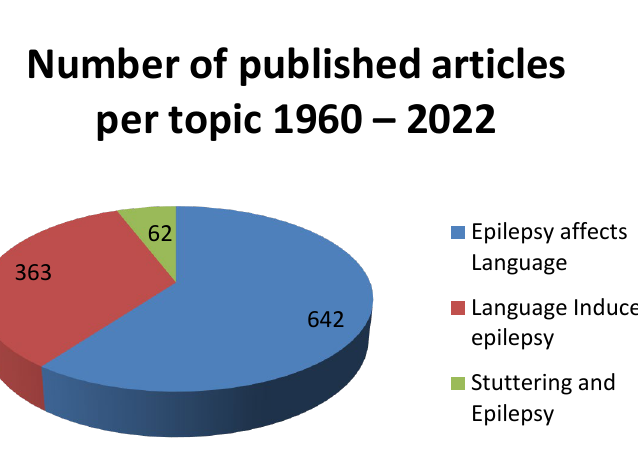
Figure 2. Number of published articles per topic 1960–2022.